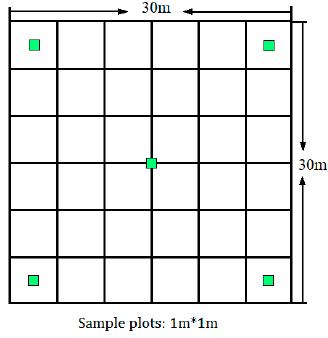
Figure 1. Study site, Yucheng County, Shangdong Province, China.